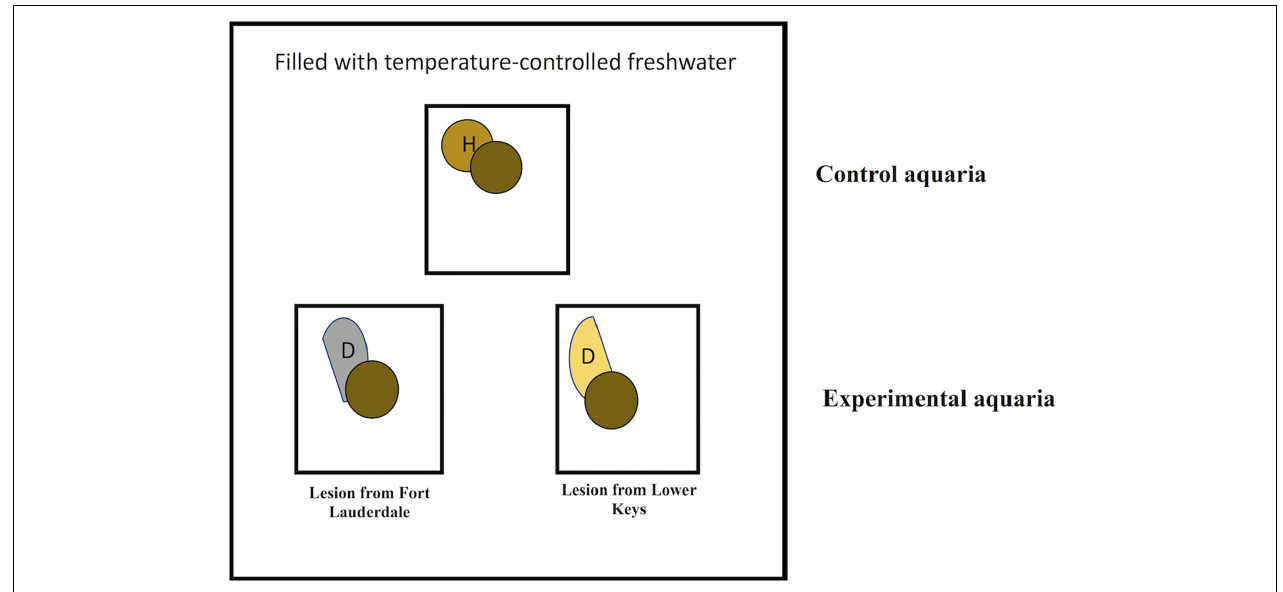
FIGURE 1 | Schematic showing experimental design for transmission studies in aquaria contained within a larger temperature controlled water table. Circles with the same color indicate coral fragments collected from the same